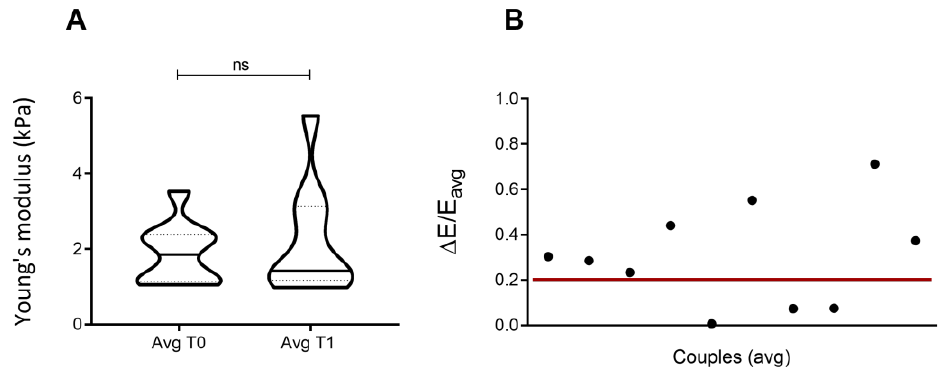
Figure 7. Averaged results from matrix Indentation, 1 min after the first indentation (line 1). ( A ) Distribution of average elasticity values in the cell population (average value from nine indentations per cell, at 300 nm, in different cell regions). ( B ) Normalized difference between elasticity values of each cell, obtained from the two consecutive indentations (average value from nine indentations per cell, at 300 nm, in different cell regions). The statistical analysis relies on the non-parametric Kolmogorov – Smirnov test.